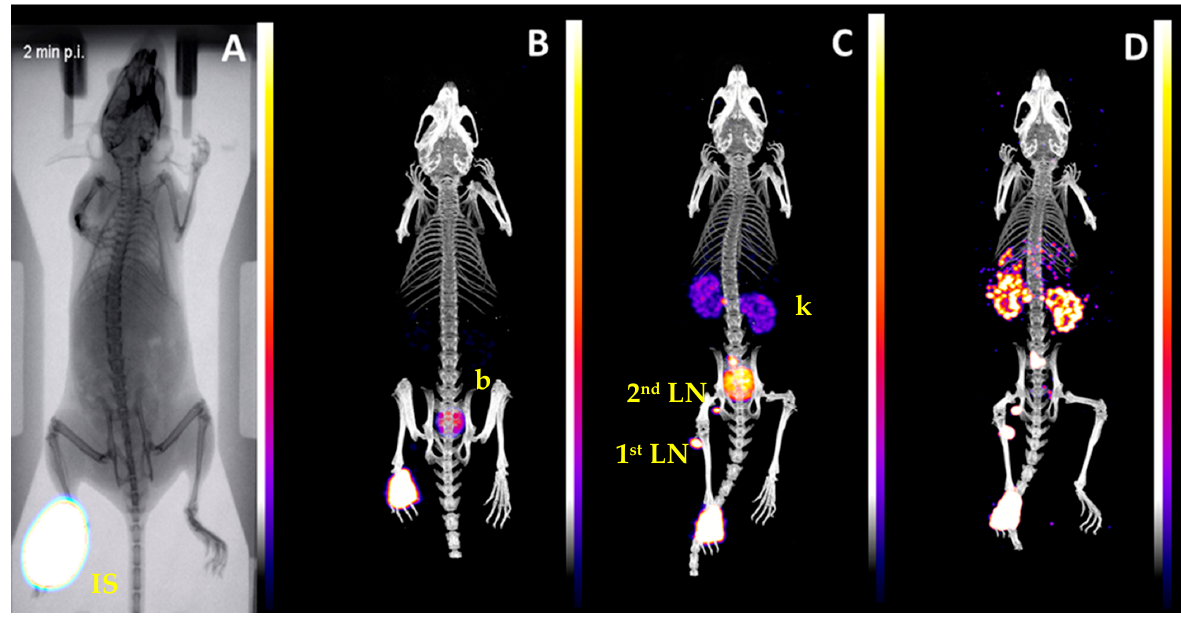
Figure 5. 2D and 3D imaging after footpad injection of the 99m Tc-labeled non-mannosylated dextran agent 99m Tc-D75C in healthy Swiss Albino mouse. ( A ) Dynamic imaging for 30 min just after injection with γ -eye ΤΜ . ( B ) Tomographic imaging for 30 min at 1 h p.i., ( C ) tomographic imaging for 30 min at 3 h p.i., and ( D ) tomographic imaging for 50 min at 24 h p.i. with x-CUBE TM /y-CUBE TM , respectively. The color bar indicates the accumulation level (i.e., white being the highest and purple the lowest). 1st lymph node (1st LN); 2nd lymph node (2nd LN); Bladder (b); Kidney (k); Injection site (IS).